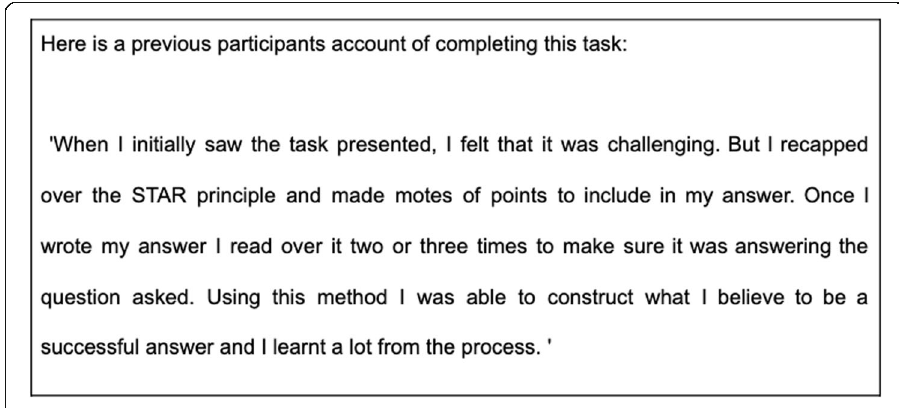
Fig. 3 Participant testimonials (High level of success